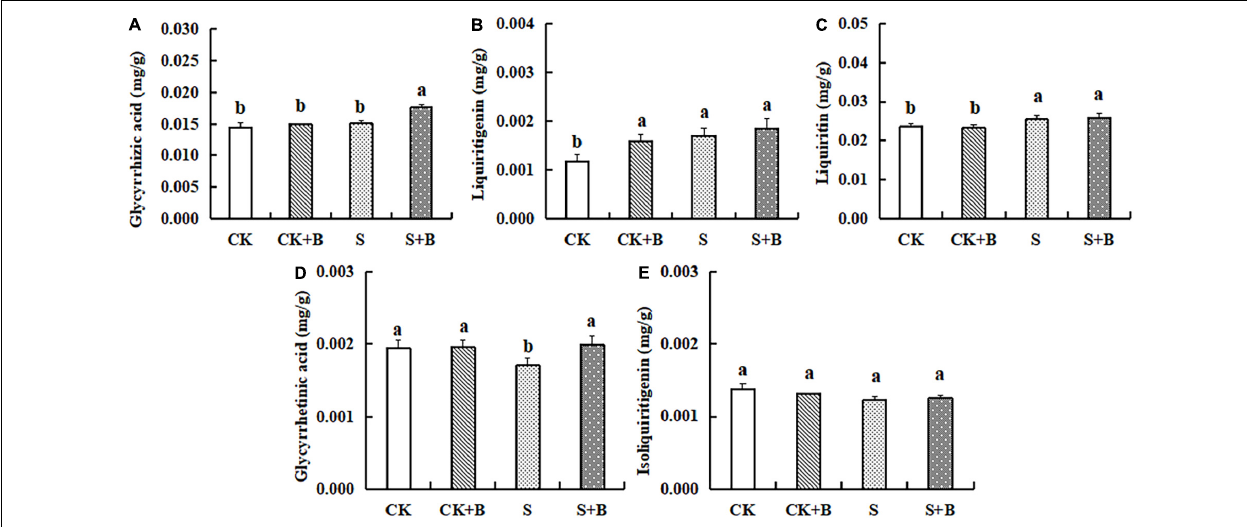
FIGURE 2 | Effect of B. cereus on the content of (A) glycyrrhizic acid, (B) liquiritigenin, (C ) liquiritin, (D) glycyrrhetinic acid, and (E) isoliquiritigenin of G. uralensis under control (CK) and salt stress (S) conditions. Data are expressed as the mean ± SE ( n = 6). The different letters within the different treatments indicate the significant difference at P <